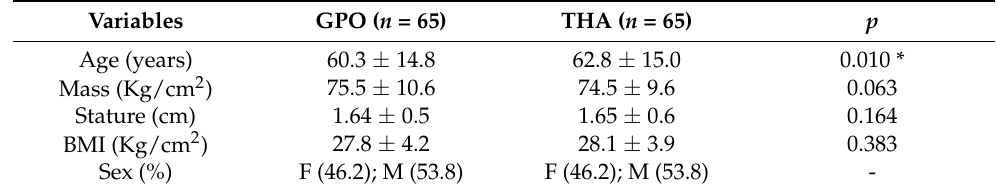
Table 1. Comparison of anthropometric aspects baseline of the surgical treatment (GPO) and after a two-year follow-up of total hip arthroplasty (THA) in older patients with unilateral osteoarthritis.